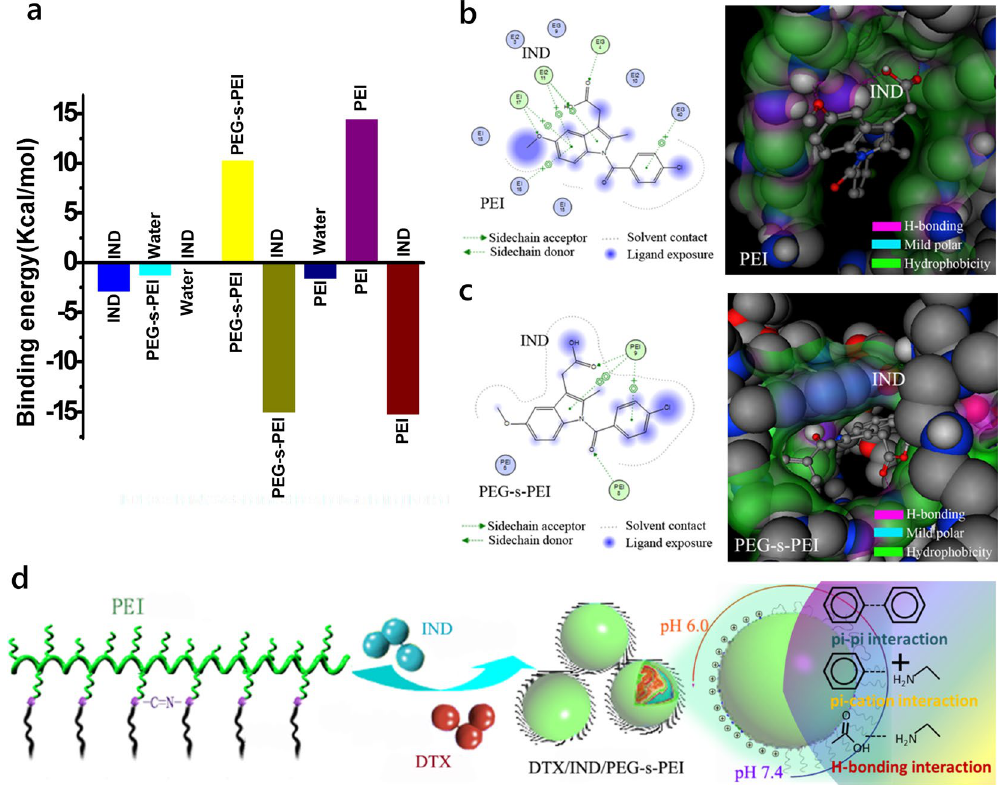
Figure 2. PEI and PEG-s-PEI interactions with IND based on the docking into ploymers. ( a ) The calculated bind energy of various components in IND/polymer mixtures stimulated by computational simulation. ( b , c ) Lowest energy 2D (left) and 3D (right) comformation of IND in case of IND docked into PEI ( b ) and PEG-s- PEI ( c ). ( d ) Schematic drawing of pH-sensitive PEGlyation cleavable PEGlyated nanoassemblies assembled by DTX, IND and PEG-s-PEI. In 3d styles, the color code for the drug and polymer is based on the atom type: in gray are the carbons, in red oxygen atoms, in dark blue are nitrogen atoms and in light gray are the polar hydrogen atoms that are forming H-bonds. The surface sites of interaction was drawn and colored by Connolly method built in